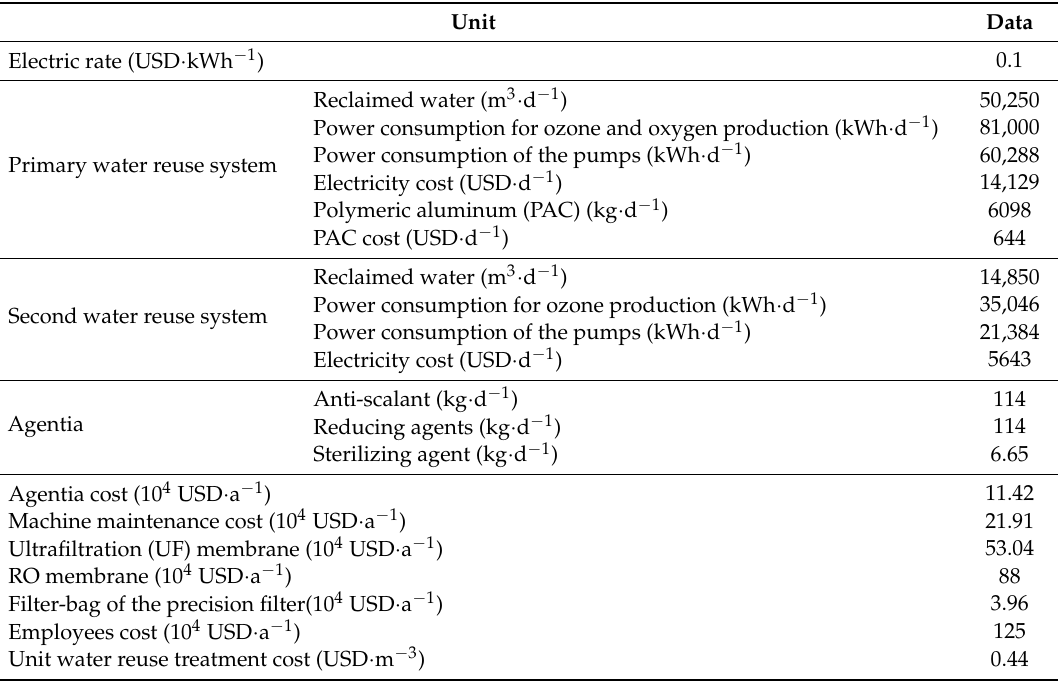
Table 6. Operating cost of the combined process .